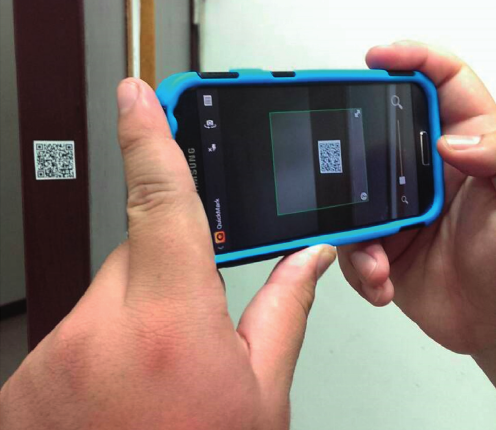
Figure 8: Scanning QR code by a mobile device.